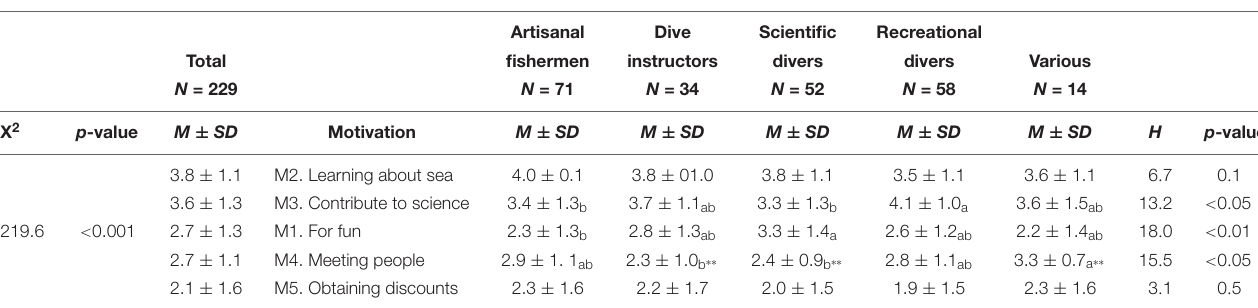
TABLE 6 | Motivations to participate in CS for each diver